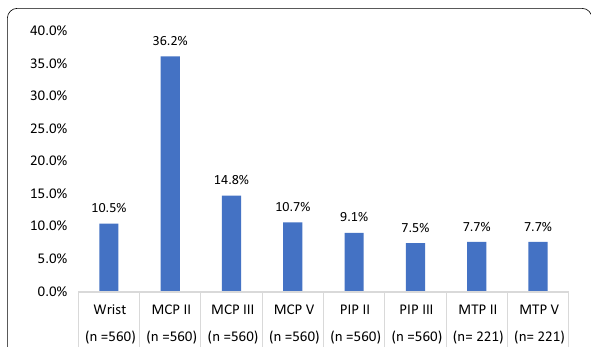
Fig. 4 Osteophytes in MSUS. Percentage of sonographically detectable OA signs of the investigated joints. These include the dorsal, palmar and ulnar wirst, the metacarpophalangeal joints 2, 3 and 5 (MCP-II, MCP-III and V), as well als the proximal interphalangeal joints 2 and 3 (PIP-II and III) with were investigated in 560 participants. Additionally, the metatarsophalangeal joints 2 and 5 (MTP-II and V)